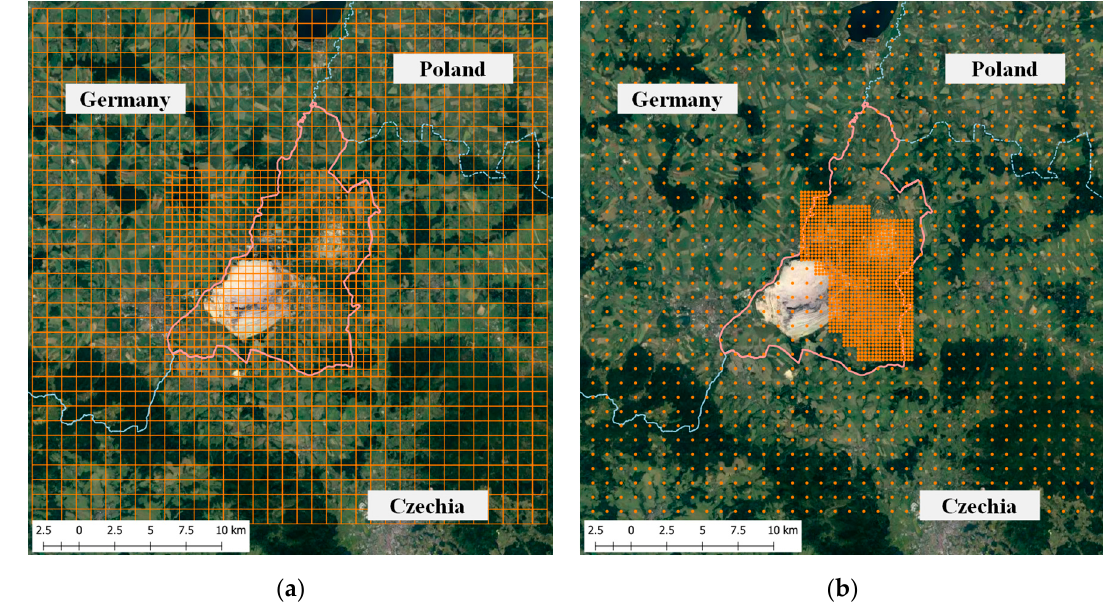
Figure 3. Parametrization of grids and receptors in the model: ( a ) meteorological grid; ( b ) discrete receptors (source: own study; map background: https://www.google.pl/maps ).